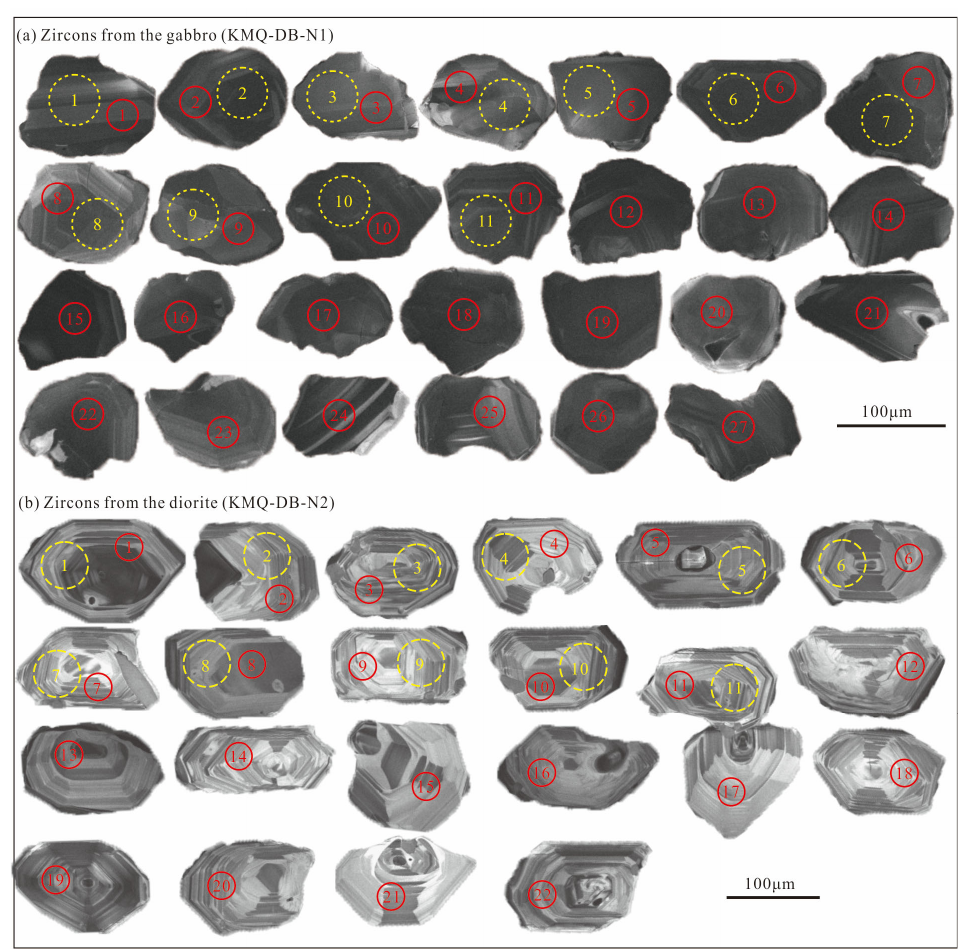
Figure 4. Cathodoluminescence images of zircon from ( a ) gabbro and ( b ) diorite. Red and yellow circles indicate the sites of U–Pb and Lu–Hf isotope analysis, respectively, and the numbers within circles refer to the analysed spots.